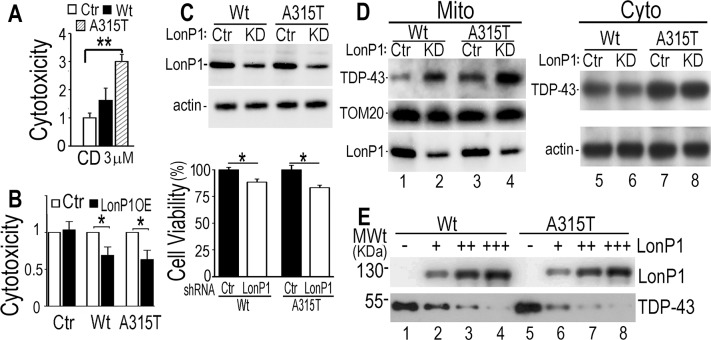
LonP1 degrades TDP-43 in cultured cells and in vitro.Treatment by the LonP1 inhibitor enhances TDP-43 induced cytotoxicity. (A, B) CD treatment enhanced, whereas LonP1 overexpression suppressed, TDP-43 induced cytotoxicity. Data in panels A and B represent 4 independent experiments (*: P<0.05, **: P<0.01; Student’s t-test). (C, D) Down-regulating LonP1 increases TDP-43 induced cytotoxicity. Control or shRNA specifically targeting LonP1 was transduced into inducible TDP-43 stable cells expressing either Wt or A315T-mutant TDP-43. Cell viability was measured 48 hr following induction of TDP-43. Down-regulating LonP1 significantly reduced viability of cells expressing either Wt or A315T-mutant TDP-43. Fractionation experiments revealed that mitochondrial TDP-43 levels were increased in cells in which LonP1 level was down-regulated (D). (E) TDP-43 protein was degraded by the purified recombinant LonP1 protein in an in vitro degradation assay. Wt or A315T-mutant TDP-43 protein was purified from the inducible HEK293 cells and incubated with increasing concentrations (0.5, 1.5 and 2.5 uM) of purified recombinant LonP1 (see Methods). The reaction products were analyzed by Western blotting using specific antibodies against TDP-43 and LonP1. Data in panels C-E represent three independent experiments.